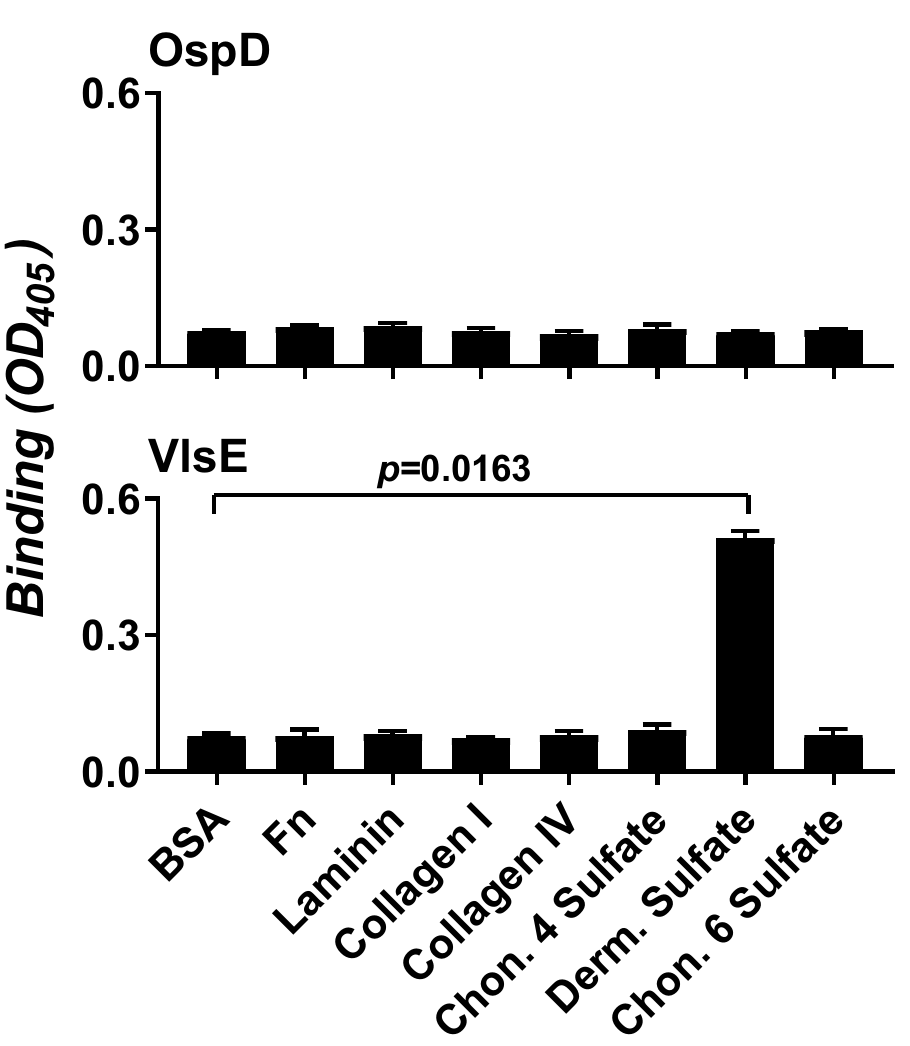
Fig 1. ELISA assay to investigate the binding of VlsE to ECM components. Two μ M of recombinant, untagged OspD (top panel, control) or VlsE (bottom panel) from B . burgdorferi B31 A3 in 100 μ l of PBS were added in microtiter wells coated with one μ g of purified BSA (negative control), fibronectin (FN), laminin, type I collagen (Collagen I), type IV collagen (Collagen IV), chondroitin-4-sulfate (Chon. 4 Sulfate), DS, or chondroitin-6-sulfate (Chon. 6 Sulfate). Protein binding was measured by ELISA in three independent experiments. Each bar represents the mean ± SD of levels of binding from three experiments. Significant differences (P < 0.05, Kruskal-Wallis test with the two-stage step- up method of Benjamini, Krieger, and Yekutieli) in the levels of indicated ligands relative to those of BSA are